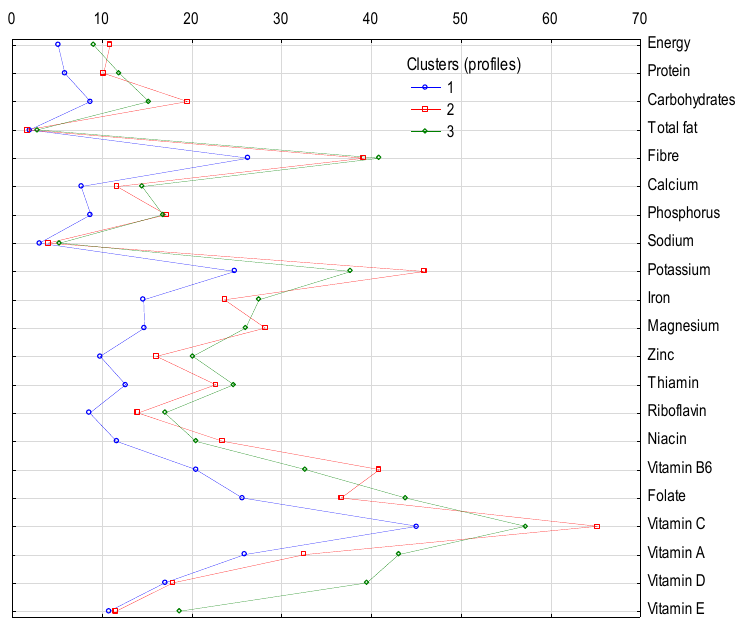
Figure 1. Cluster analysis: percentage contribution of selected nutrients from vegetables, potatoes, and their products.